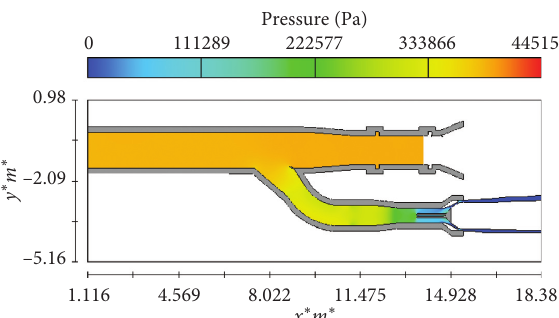
Figure 28: Pressure changes in the bottom outlet’s tunnel of Sardab Dam for a fully closed gate and 100% open branch valve.